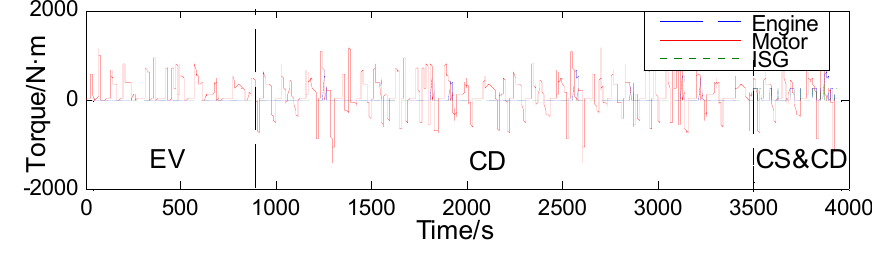
Figure 16. Power components torque contrast.